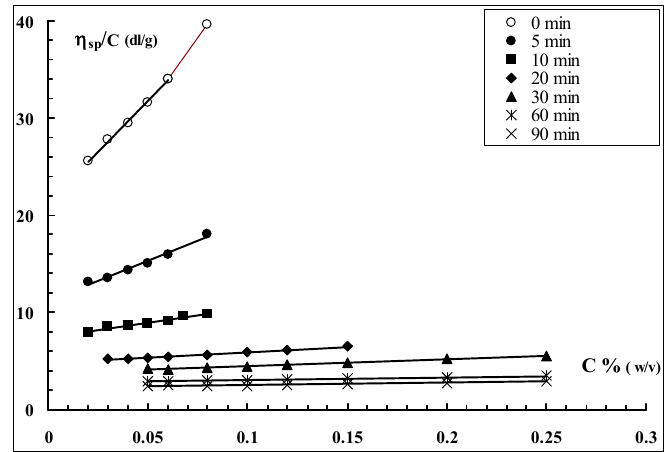
Figure 6. Plot of  /c vs. polymer concentration for Sclg samples sonicated for specific different periods of time (NaOH = 0.01 N, T = 25 °C).